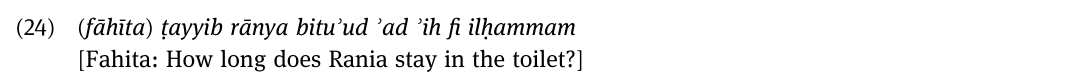
[ Fahita: How long does Rania stay in the toilet? ] Fahita also mocks Hassan ’ s disorganised wardrobe in ( 25 ) . Her use of the action verb tul ṭ um [ slap your face ] is cultural since this physical gesture is associated with severe shocks in Egyptian